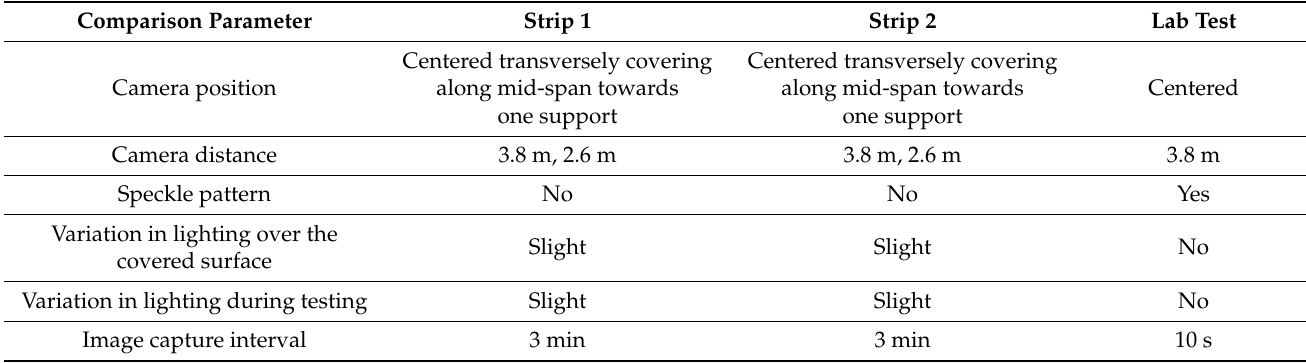
Table 1. Comparison of DIC test setup, along with observations from